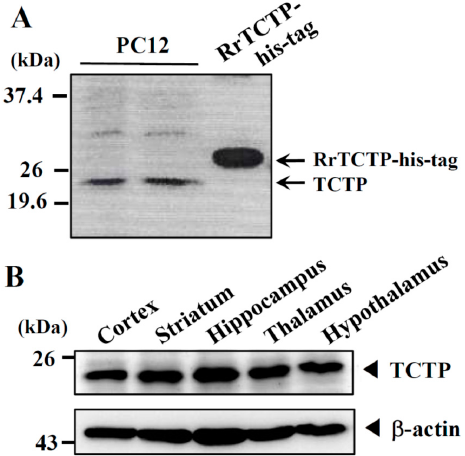
Figure 1. Endogenous translationally controlled tumor protein (TCTP) expression in PC12 cells and rat brain. Proteins extracted from PC12 cells (3 × 10 6 cells, about 40 µg; ( A )), recombinant RrTCTP-his-tag (10 µg; ( A )); and rat brain tissues (indicated regions, 40 µg; ( B )) were analyzed by